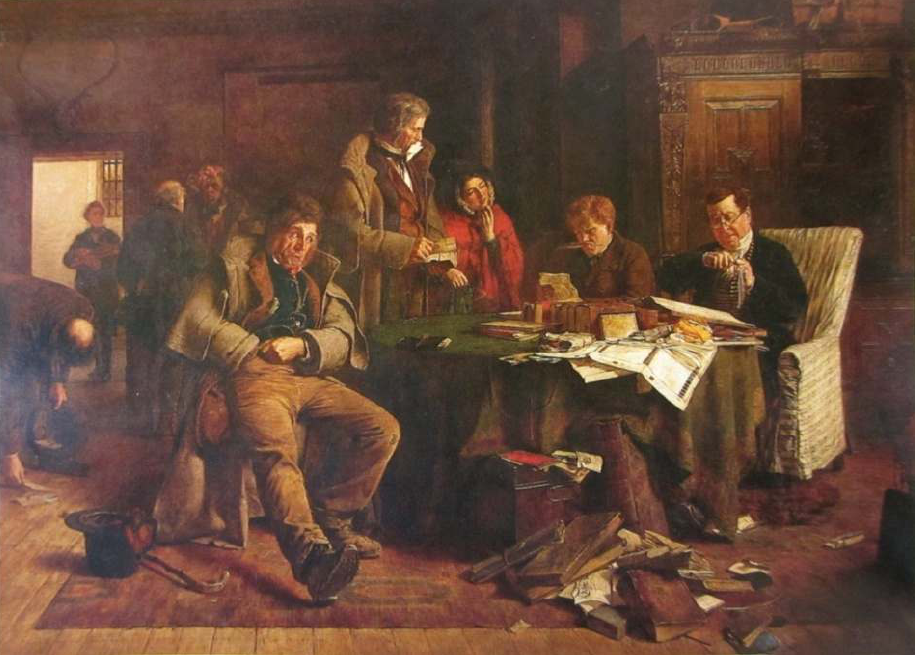
© Amélie Dochy, All rights